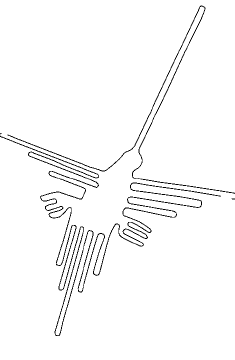
Figure 3. The most popular geoglyphs: Hummingbird, 95 m